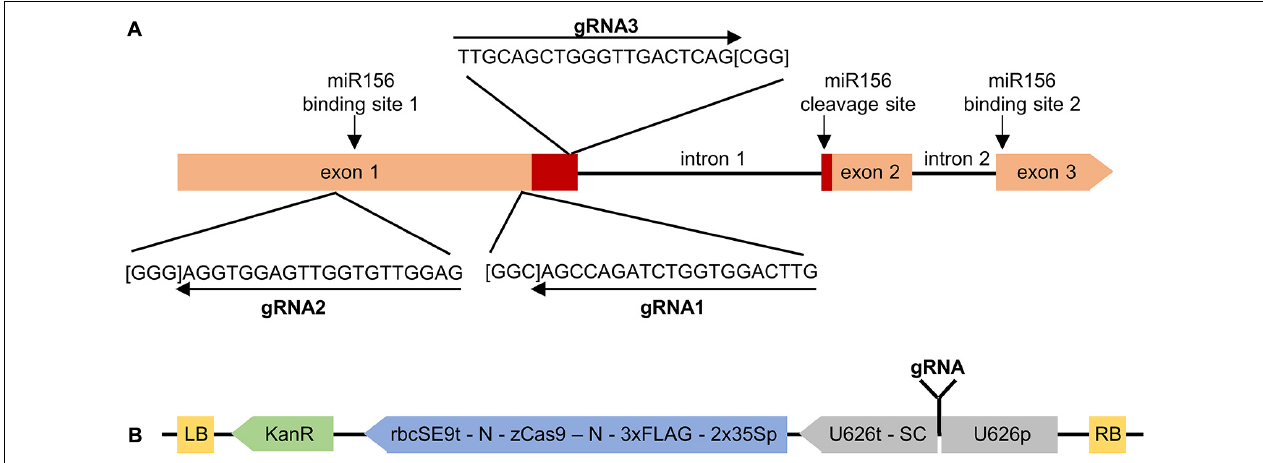
FIGURE 1 | Targeting MsSPL8 alleles for NHEJ-based editing using CRISPR/Cas9. (A) Genomic structure of MsSPL8 alleles and gRNA target regions. The region encoding the SBP domain is displayed in red and PAM sequences are indicated in square brackets. miR156 binding and cleavage sites are indicated with arrows. (B) Three gRNAs targeting different regions of MsSPL8 alleles were inserted into the pKSE401 background vector to yield SPL8-gRNA1, SPL8-gRNA2 and SPL8-gRNA3 binary vectors. 2x35Sp, partially duplicated CaMV 35S promoter; 3xFLAG, polypeptide tag; KanR, kanamycin resistance cassette; LB, left border; N, nuclear localization signal; RB, right border; rbcSE9t, pea RuBisCO small subunit E9 terminator; SC, sgRNA scaffold; U626p; Arabidopsis U6 polymerase III promoter; U626t; U6 terminator; zCas9, Zea mays codon-optimized